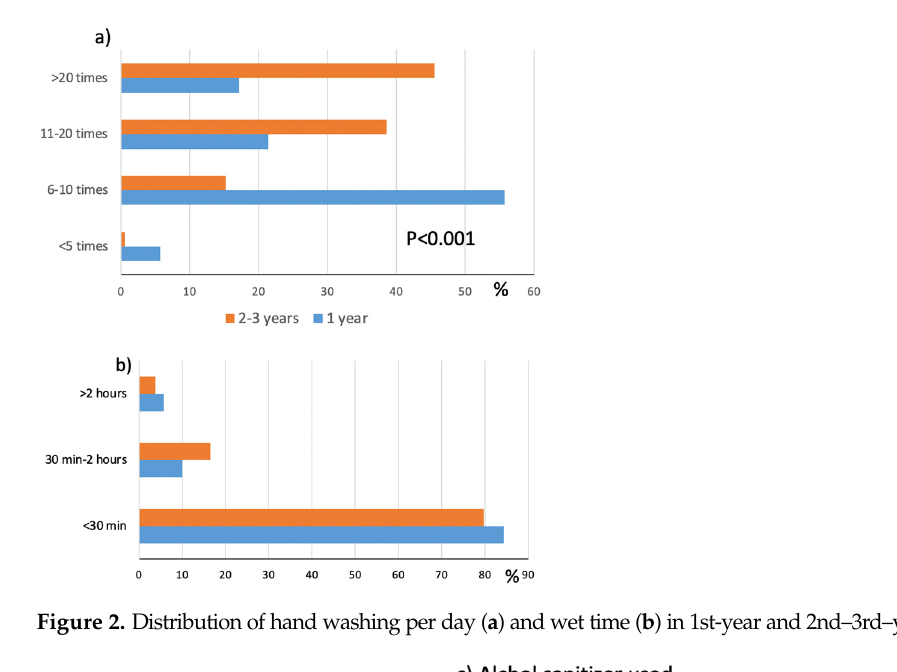
Figure 3. Impact of COVID-19 pandemic. Glove preferences ( a ), modification of hygiene habits ( b ), use of alcohol-based sanitizers ( c ), perception of own skin condition ( d ) in 1st-year and 2nd–3rd- year students.